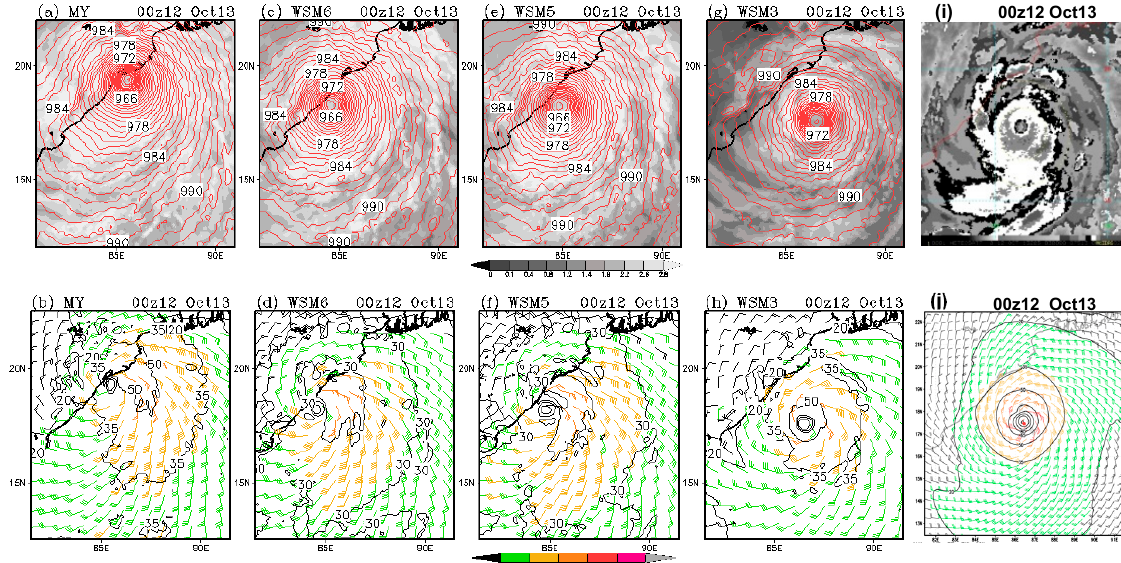
Figure 6. MSLP (hPa) and total cloud distributions (%) during the ESCS stage of Phailin derived from WRF simulation experiments using ( a ) MY, ( c ) WSM6, ( e ) WSM5, ( g ) WSM3 schemes, and ( i ) METOSAT 7 observation valid at 00 UTC, 12 October 2013 [initial condition of 00 UTC, on 8 October 2013] at 8.333 km resolutions; similarly, 10 m wind speed (shaded; knots) and direction obtained from ( b ) MY, ( d ) WSM6, ( f ) WSM5, ( h ) WSM3 schemes, and ( j ) CIRA observation respectively .